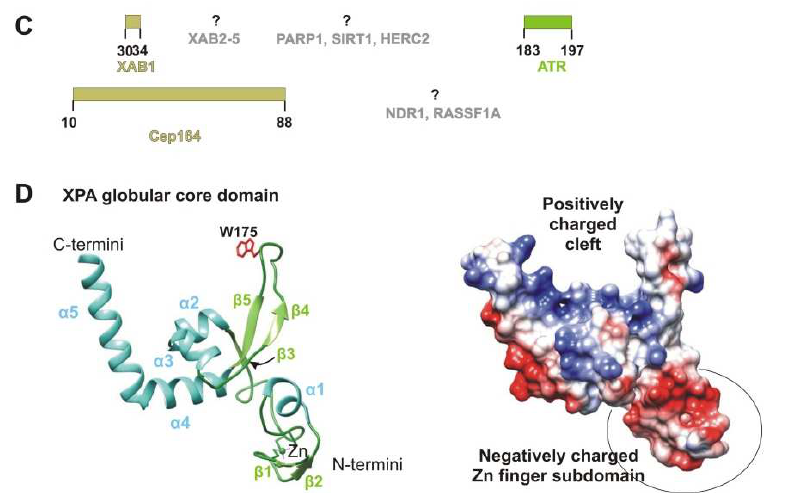
Figure 1. XPA’s structure and interaction partners. ( A ) The map of the XPA domain structure and known points of PTMs: phosphorylation at S196 and acetylation at K63 and K67. Secondary-struc- ture elements are shown according to crystal structures PDB 6LAE and 6J44: β-strands are green (β1: aa 103–104, β2: aa 111–112, β3: aa 138–140, β4: aa 164–167, and β5: aa 178–172), and α-helices are light blue (α1: aa 116–121, α2: aa 141–148, α3: aa 151–157, α4: aa 183–194, and α5: aa 197–239). Positively charged residues K141, K151, K179, R207, and R211, which are directly involved in inter- actions with backbones of a DNA duplex, are shown as blue triangles. Two residues (Thr140 and Thr142, indicated as purple triangles) interact with the DNA backbone through a van der Waals contact and a hydrogen bond, respectively. Extended helix α5 contains several positively charged residues (Lys217/218/221/222/224/236 and Arg227/228/231/237) that are possibly involved in DNA binding, which are shown as a blue striped box. Conserved residue Trp175 intercalates into unpaired bases of single-stranded DNA (ssDNA) at the ss–dsDNA junction and is displayed as a red circle. Unstructured N- and C-terminal regions are gray. Zinc-coordinated conserved cysteine residues (C105, C108, C126, and C129) are presented as red asterisks and a Zn-finger motif (ZnF, aa 102–129) colored green. The N terminus accommodates a nuclear localization signal (NLS, aa 30–42), which is yellow. DNA-binding (aa 98–239) and poly(ADP-ribose) (PAR)-binding (aa 213–237) motifs are mapped to the overall XPA structure and are highlighted in dark blue. ( B ) Interaction sites for NER protein partners on XPA, which are aligned with the XPA residues involved in each interaction. Proteins whose interaction sites are unknown are gray. ( C ) XPA interaction partners outside NER. ( D ) A structural model of the XPA globular core domain (PDB ID: 6LAE). A ribbon diagram with color codes according to ( A ). The Trp175 residue is shown in red. A distribution of the electrostatic potential on the surface for the same structure: a positive charge is shown in blue, and a negative charge is red. The structures were generated using UCSF Chimera software (version